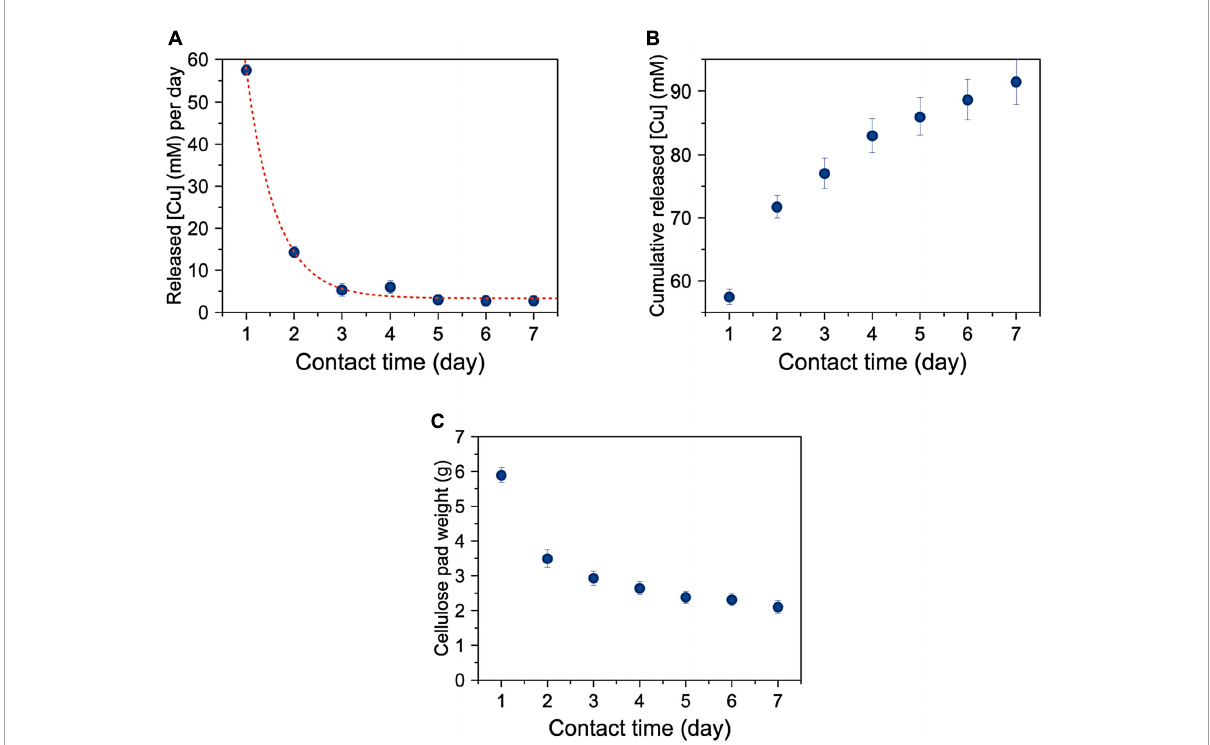
FIGURE6 (A) Mean concentration of released Cu per day as a function of time with a cellulose pad renewed each 24 h of contact. Red line is a first-order exponential best fitting experimental points; (B) Cumulative Cu released as a function of time; (C) Mean weight of cellulose pads used for 7 days experiment and renewed after of 24 h of